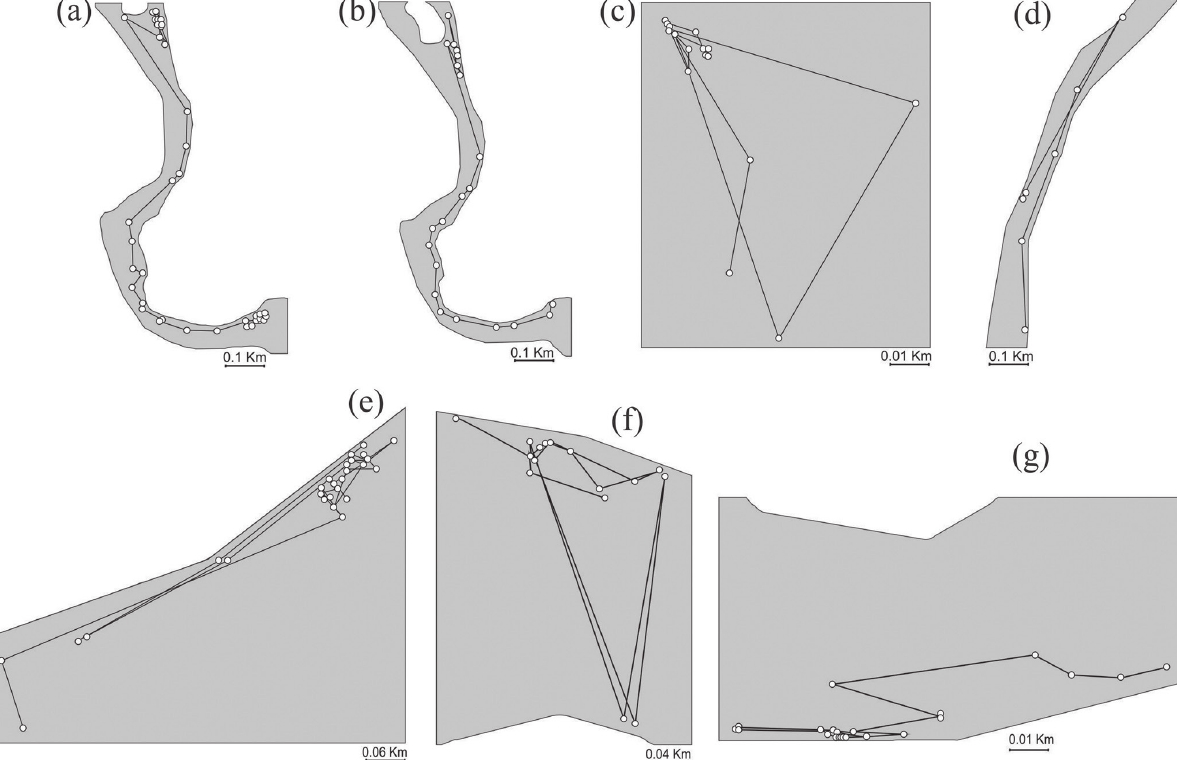
Fig. 2. River sections showing movement patterns (black lines) for each of the seven individuals of Diplomystes camposensis studied. a) RT 13, b) RT 14, c) RT 52, d) RT 61, e) RT 62, f) RT 63, g) RT 67. Note that scales are different in each case.